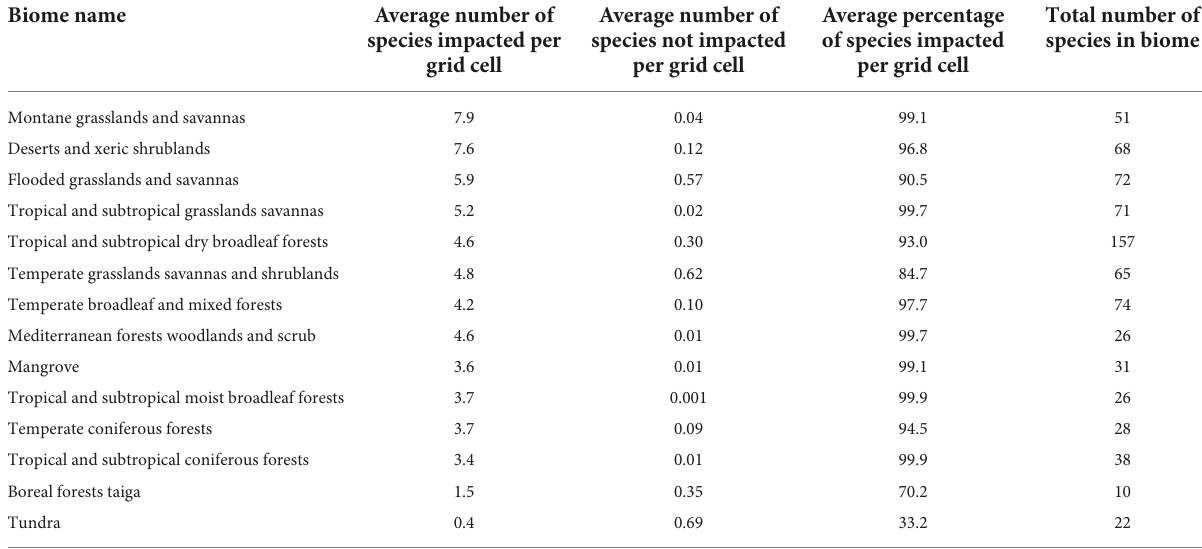
TABLE 3 The average number and proportion of raptor species impacted or not impacted by threats, including the total number of raptors, in each of Earth’s biomes as defined in Olson et al.